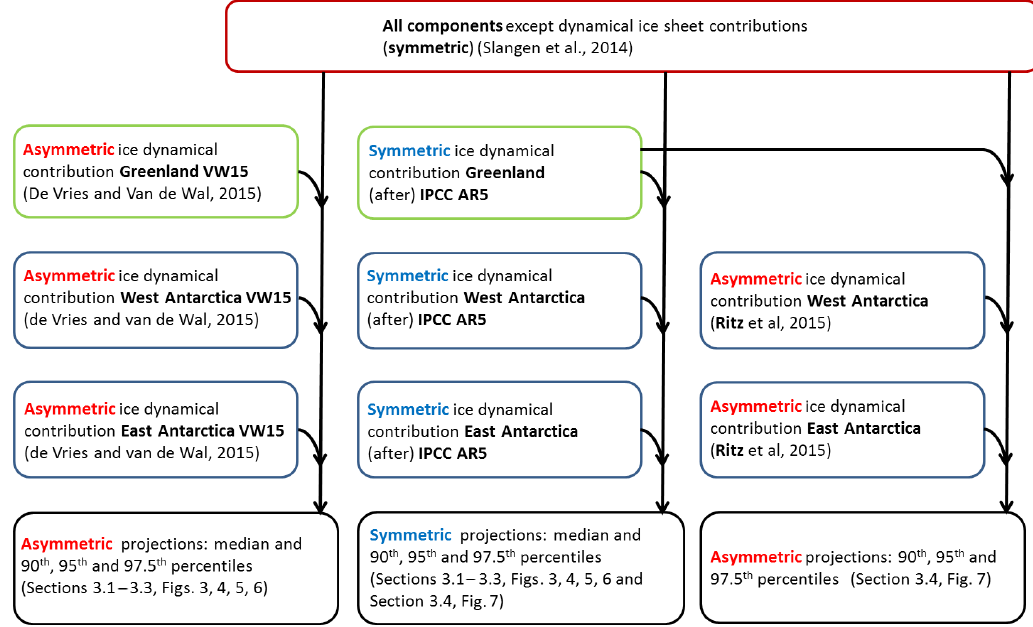
Figure 2. Overview of the used data: which data are combined and in which section the computations are discussed. Each box represents a distribution for the global average; these global average data are converted to a regional contribution using the fingerprints of Slangen et al.